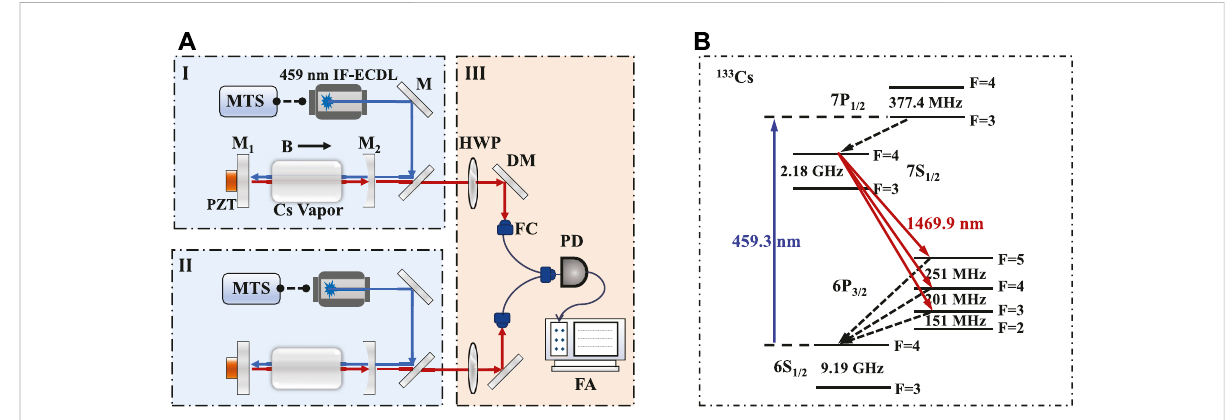
FIGURE 1 Workingprincipleofthe1,470 nmAOClaser. (A) SketchoftheexperimentalsetupforAOClasingunderaweakmagnetic fi eld.MTS,modulation transfer spectroscopy; IF-ECDL, interference fi lter con fi guration extended cavity diode laser; M, high-re fl ection coated mirror; M 1 and M 2 , cavity mirrors; PZT, piezoelectric ceramic; HWP, half-wave plate; DM, dichroic mirror coated with anti-re fl ection at 1,470 nm and high-re fl ection at 459 nm; FC, fi ber coupler; PD, photodetector; FA, frequency analyzer. (B) Hyper fi ne level scheme for the 133 Cs atom shows the 1,470 nm transition as the AOC lasing using 459 nm transition for